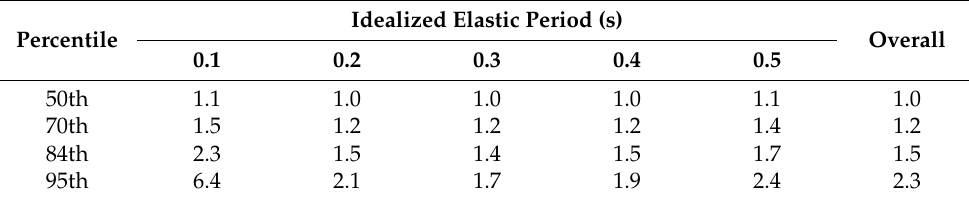
Table 3. Percentile factors of displacement predicted by the proposed OSM for various percentiles.